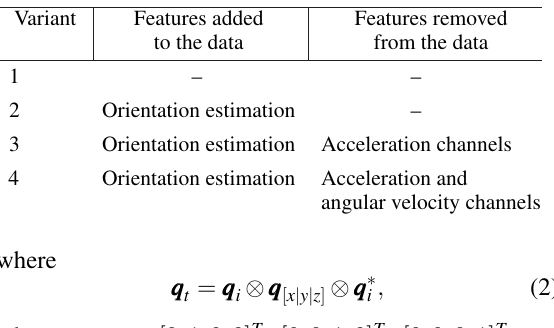
Table 3. Variants of the input data. Orientation features were calculated as described in equation